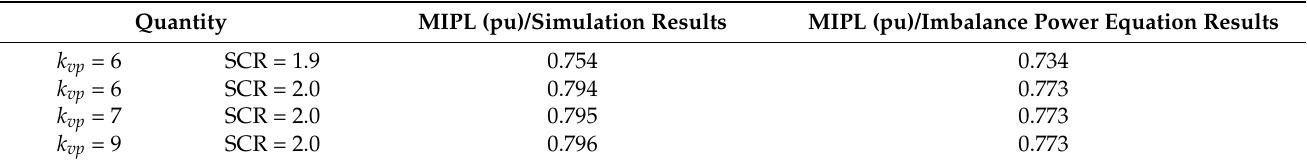
Table 2. Comparison of the Simulation Results and the Theoretical